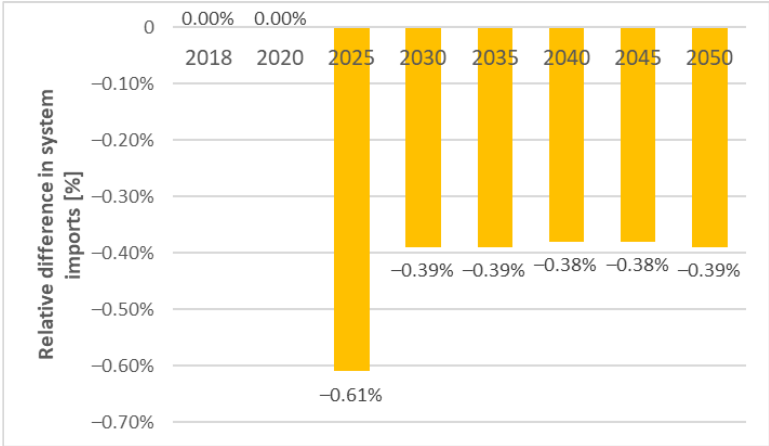
Figure 12. Effect of storage on electricity imports during peak hours.